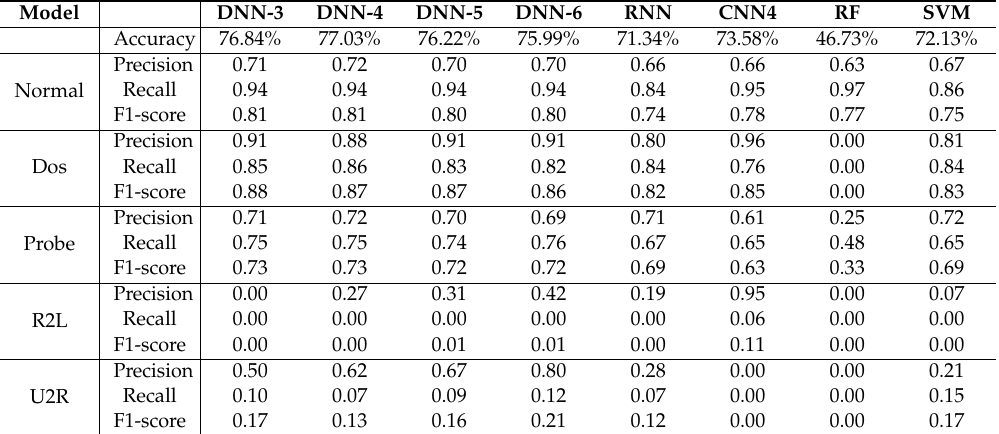
Table 6. E ff ects of di ff erent models on multi-class classification, based on NSL-KDD test set.